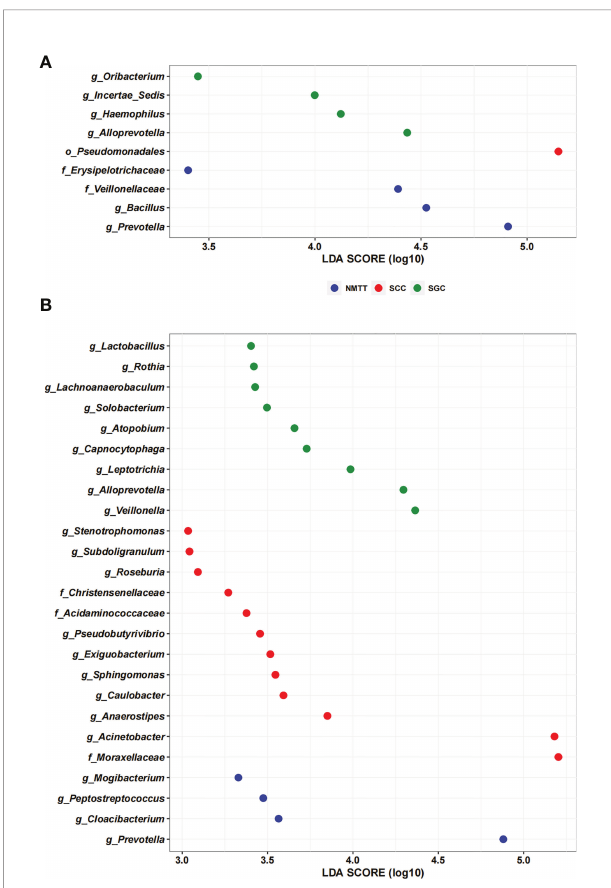
FIGURE 5 | Linear discriminant analysis effect size (LefSe) based on operational taxonomic units (OTUs) characterize microbiomes oftrachea (A) , anddistal alveoli (B) between different pathological types of tracheal tumor